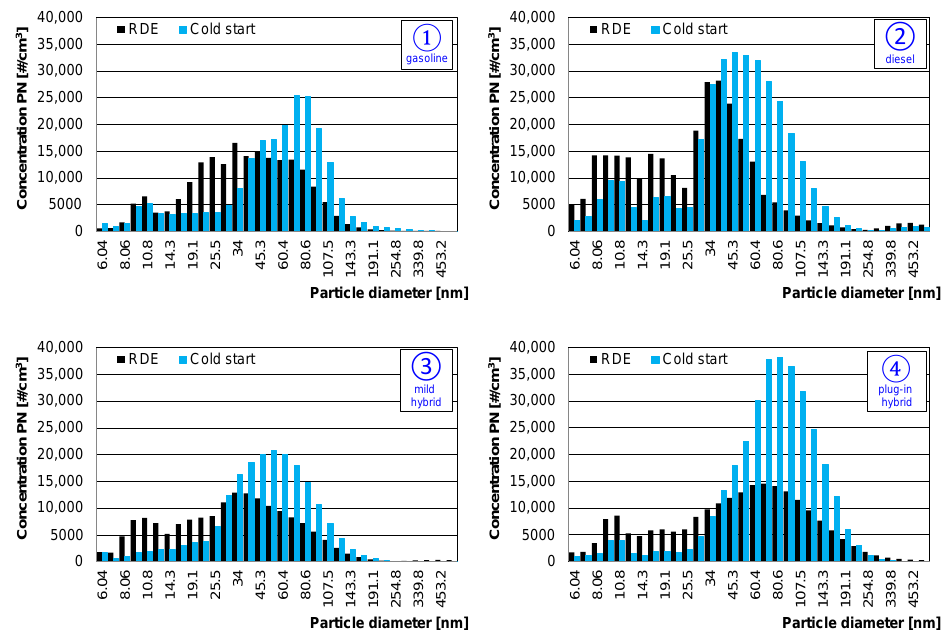
Figure 9. Number distribution of particulate matter for vehicles 1 – 4 in the cold start phase of the engine against the values obtained during the whole test; 1 — gasoline, 2 — diesel, 3 — mild hybrid, 4 — plug-in hybrid.